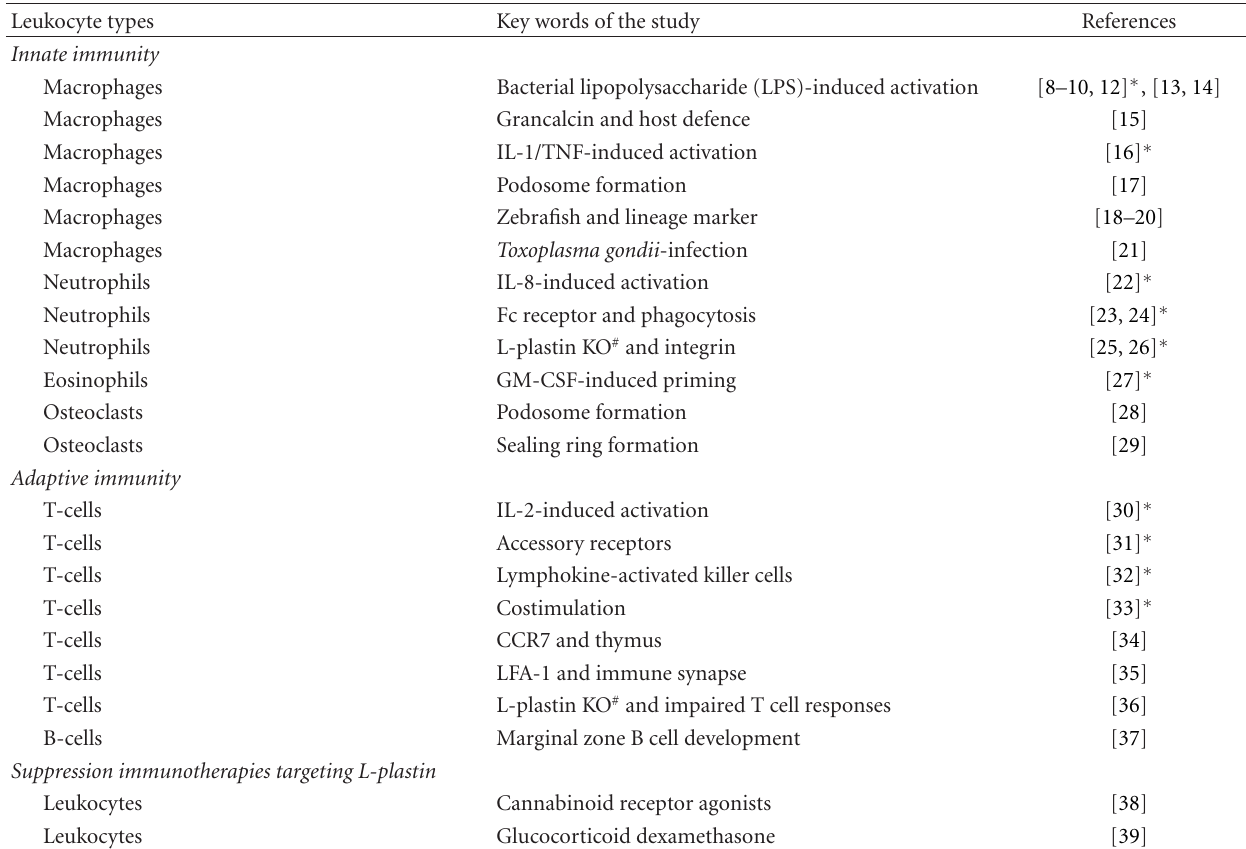
Table 2: Studies on L-plastin in